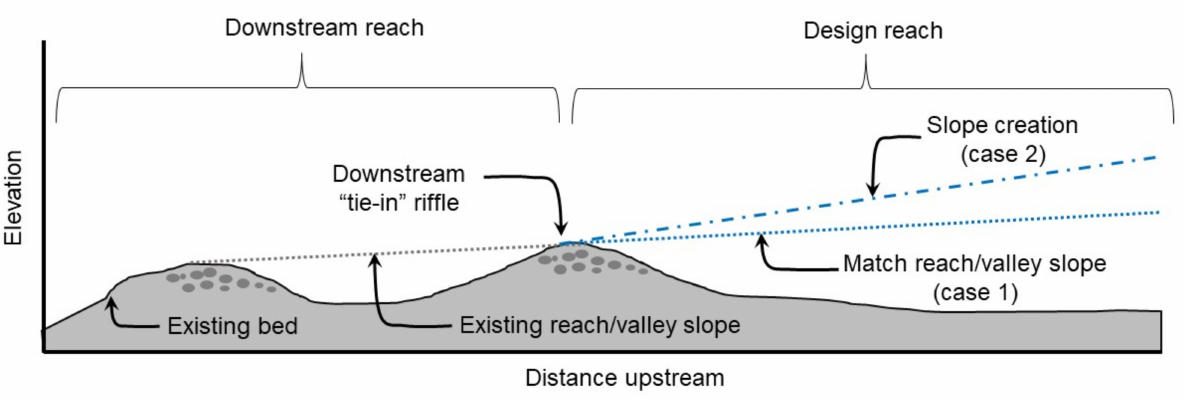
Figure 4. Conceptual long profile illustrating end-member scenarios. Case 1 is where the existing reach/valley slope is matched and extended. Case 2 is where a new gradient is imposed and is termed “slope creation” by [25]. The dashed blue lines would indicate the approximate elevation of riffles under scope creation, while the solid line would approximate the elevation of riffles for the case where the valley slope is